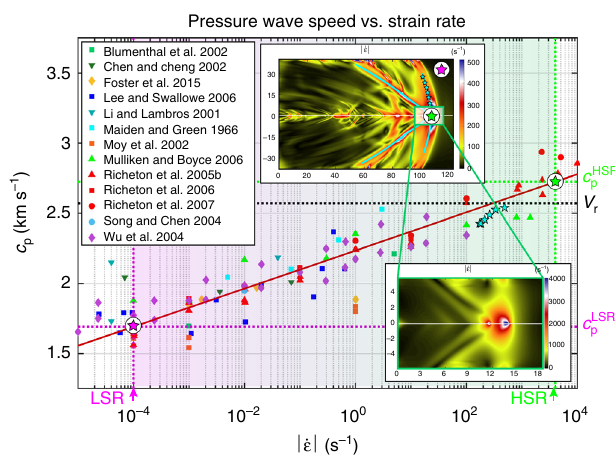
Fig. 3 Strain-rate dependence of the pressure wave speed in PMMA. The values of the pressure wave speeds c p computed based on the elastic moduli versus strain-rate data acquired from the literature as reported in the legend 32,34 – 37,48 – 55 , where the diamond symbols indicate tensile tests, as opposed to the other symbols that indicate compressive tests. The red solid line is a logarithmic fi t of this data (see Methods section). The values of c p for several locations along the pressure shock front (cyan stars), predicted from the relation (Eq. 1) between the inclination angles of the pressure shock front and rupture speed, are plotted vs. the strain rate determined at those locations. The two sets of pressure wave speeds (from the literature and from our experiments) show an excellent agreement, demonstrating that the inclination angles of the pressure shock fronts are consistent with the viscoelastic stiffening induced. The rupture speed V r = 2.57 km s − 1 (dotted black line) is higher than all of those shock-wave determined pressure wave speeds, indicating that the rupture is supersonic with respect to them. The high-strain-rate (HSR) pressure wave speed, corresponding to the strain rate of about 4 × 10 3 s − 1 at the crack tip (the blue region in the bottom inset), is determined as the wave speed on the logarithmic fi t (red line) that corresponds to that strain rate (green star). The strain-rate level at the crack tip is obtained from a similar test performed on a sample at an angle α = 29° (rather than 30°) under the same loading conditions, by focusing on a smaller fi eld of view, which enables a higher strain-rate resolution (lower inset). The low-strain-rate (LSR) pressure wave speed (see Discussion section) corresponds to the purple star. The green and purple vertical dashed lines refer to the equivalent strain-rate levels for these near- fi eld and far- fi eld measurements, and the corresponding predicted values of the pressure wave speeds are indicated by the horizontal green and purple dashed